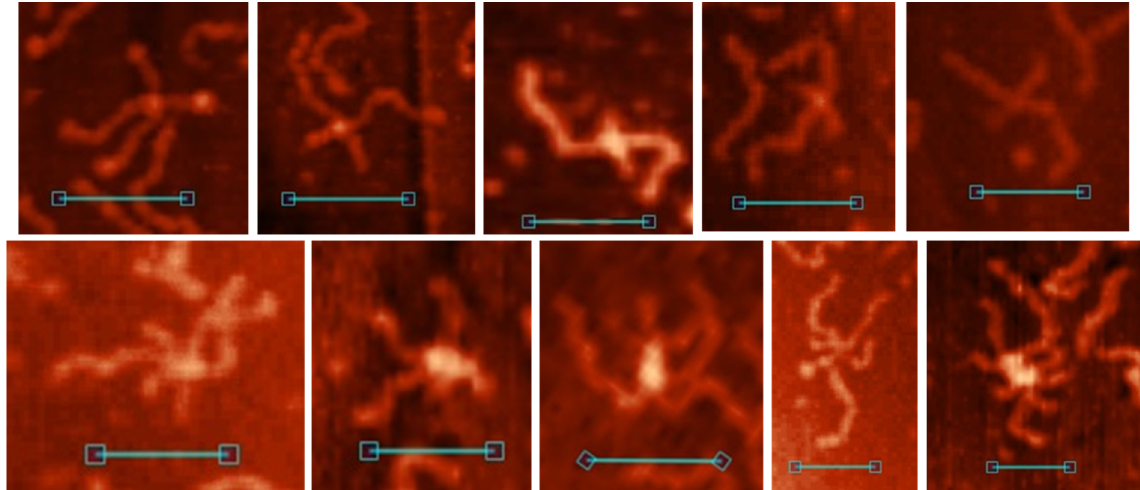
Figure 8. Di ‐ and multimeric G4/IM ‐ synaptic complexes, formed by 5s sample.